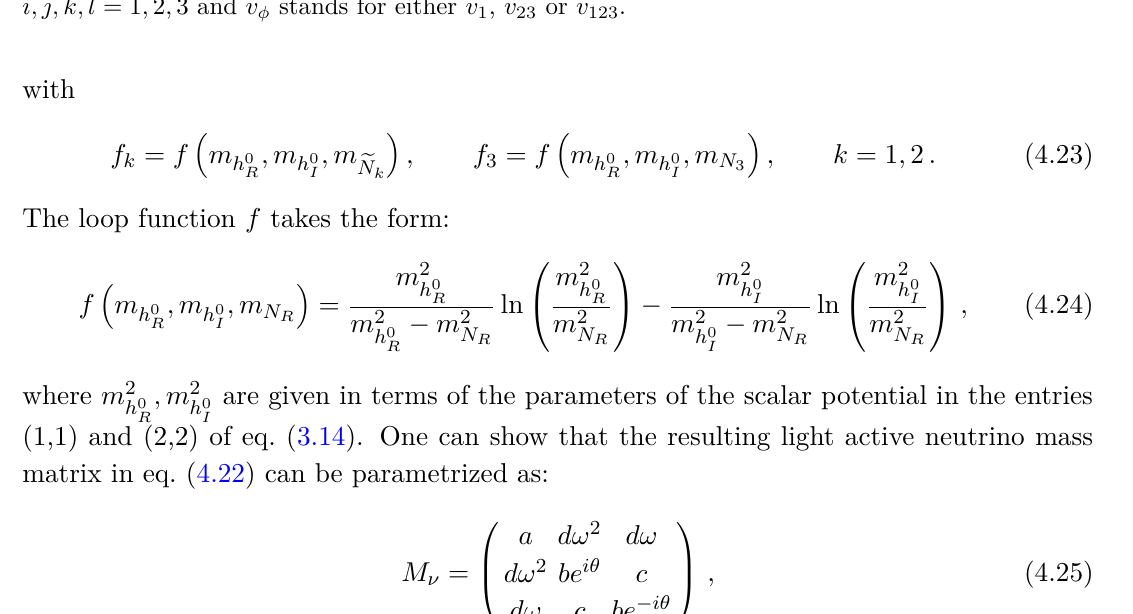
Figure 2 . One-loop Feynman diagram contributing to the light active neutrino mass matrix. Here i, j, k, l = 1 , 2 , 3 and v φ stands for either v 1 , v 23 or v 123